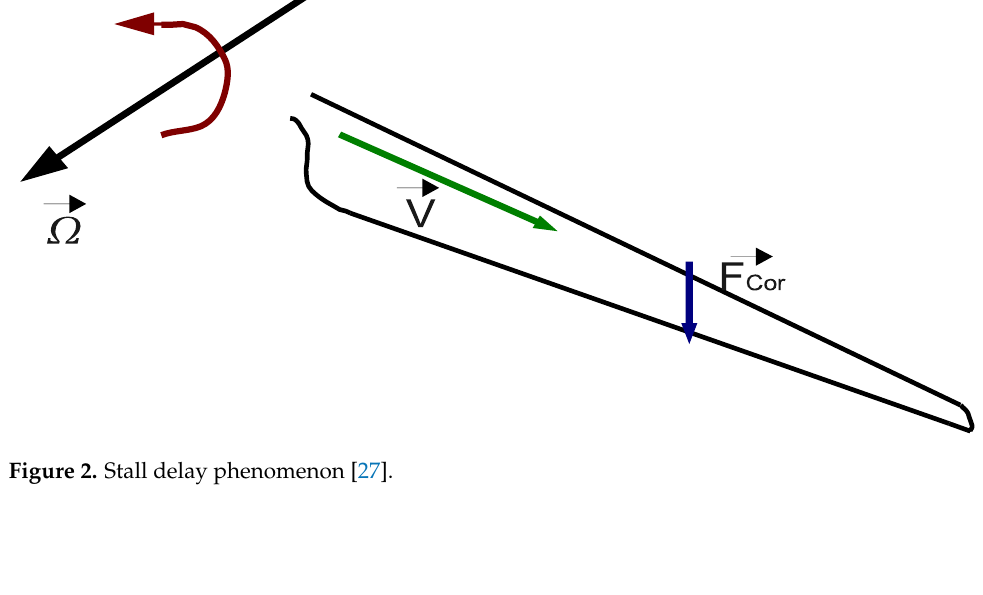
Figure 2. Stall delay phenomenon